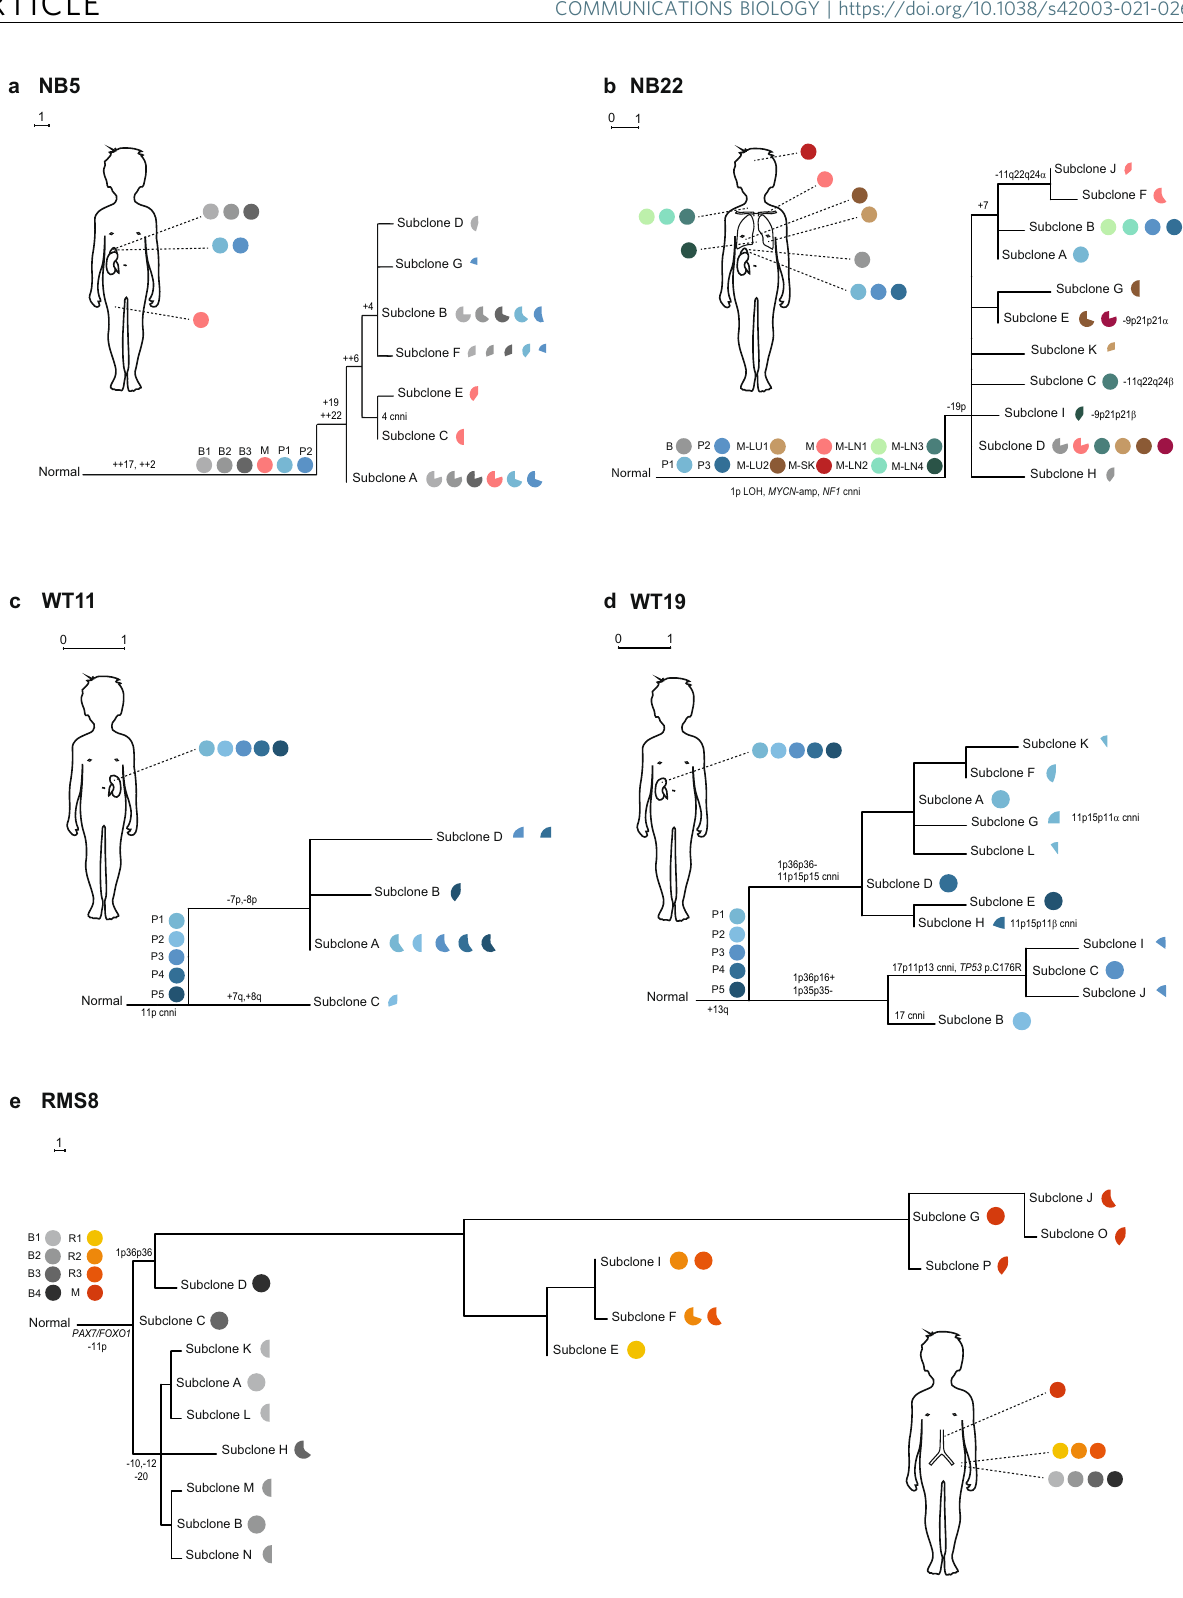
escape the primary tumor and colonize the lymph nodes is lower than that for colonization of distant organs, displayed as a wider variety of different subclones across lymph node locations compared to an extensive selection for a certain subclone in distant loci. RMS8, an alveolar rhabdomyosarcoma (Fig. 2e), displayed an intricate evolutionary pattern with many genetic alterations. Here the primary tumor ’ s subclones form a cluster